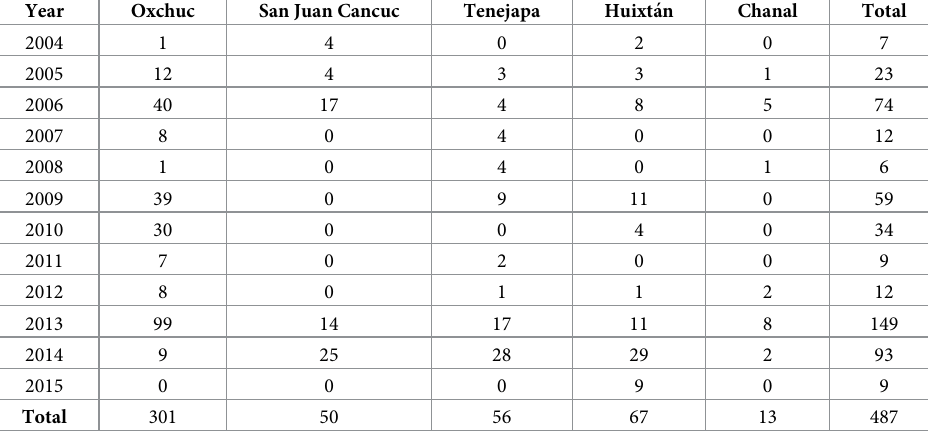
Table 3. TT operations carried out in Chiapas, Mexico, 2004–2015. Source: State Program for the Prevention and Control of